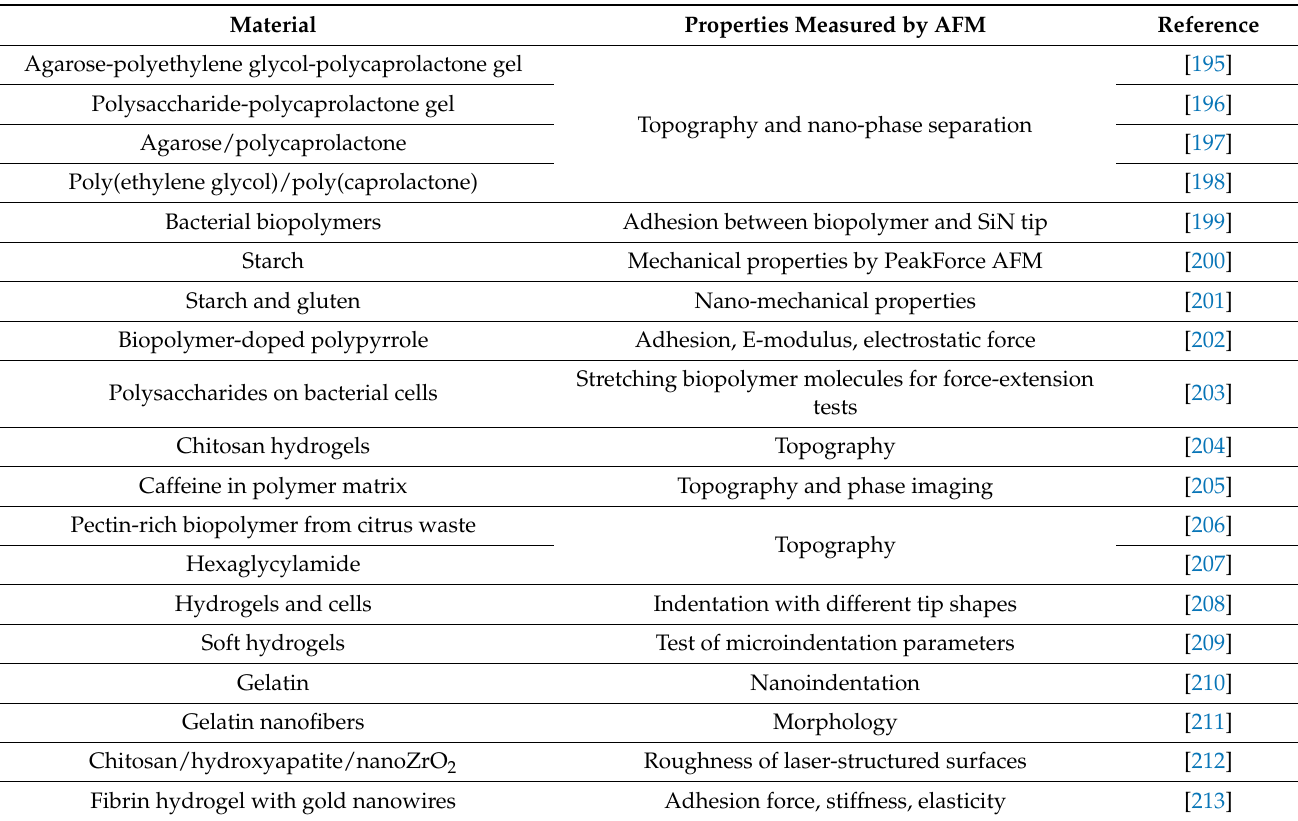
Table 2. Examples of other biopolymers and hydrogels, investigated by